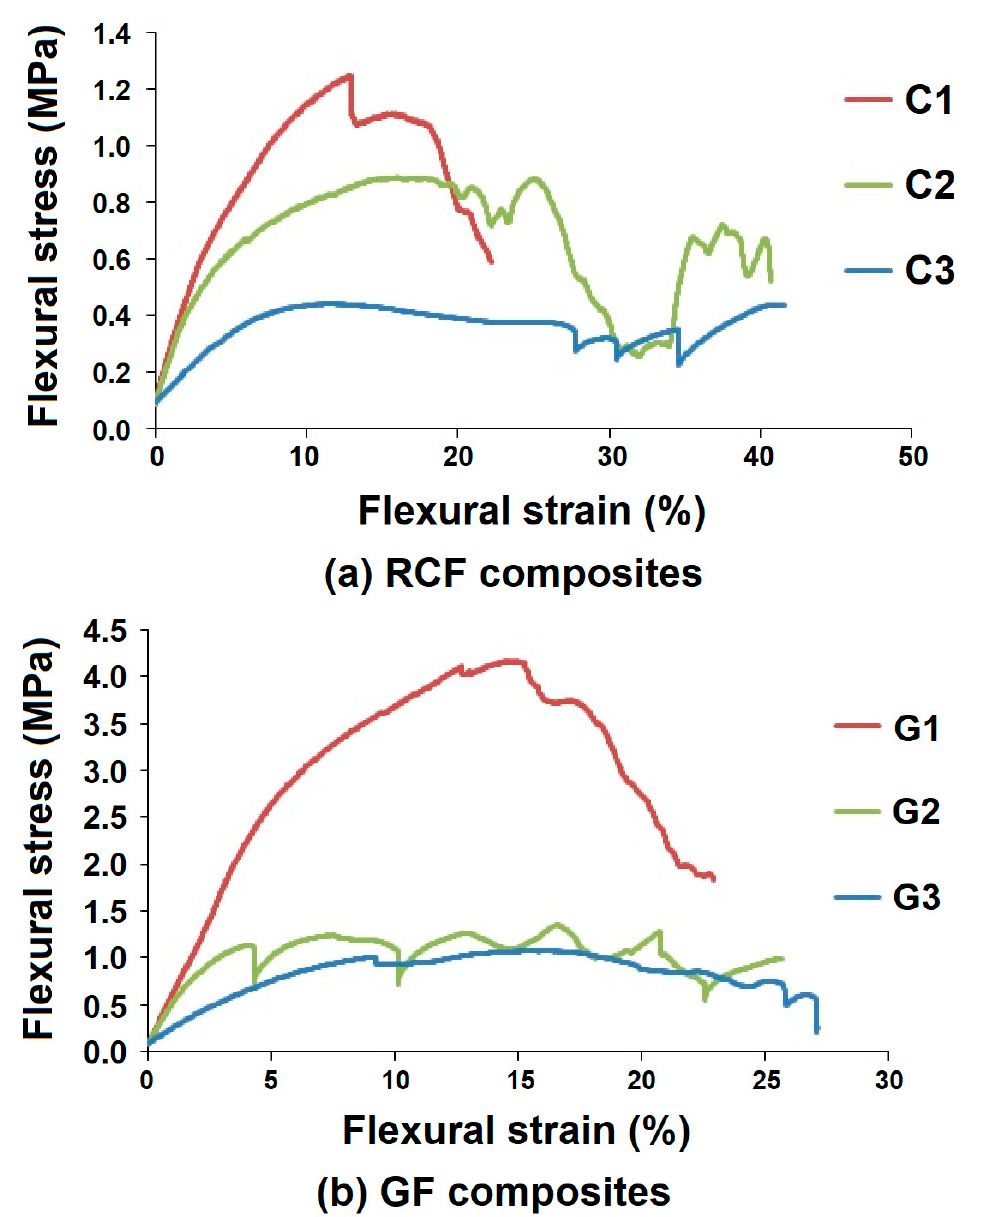
Figure 10. Flexural stress versus strain of ( a ) recycled cotton fiber-based hollow composites and ( b ) glass fiber-based hollow composites.